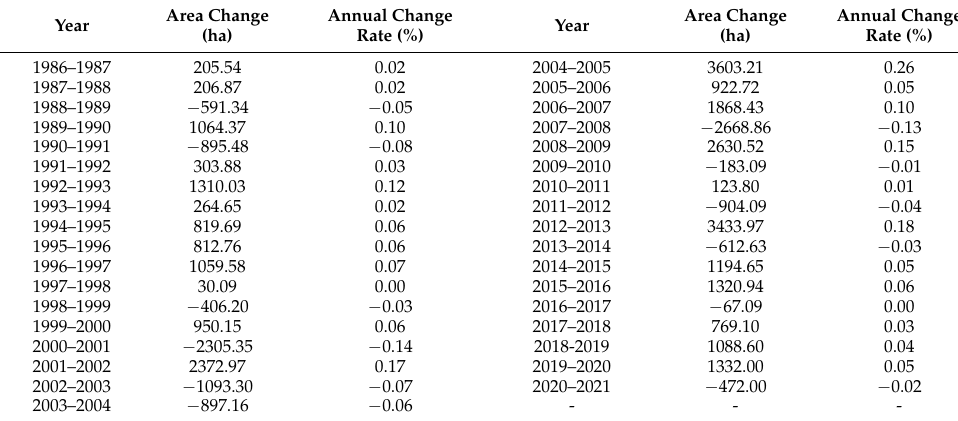
Table 4. Change area and annual rate of mangrove change in